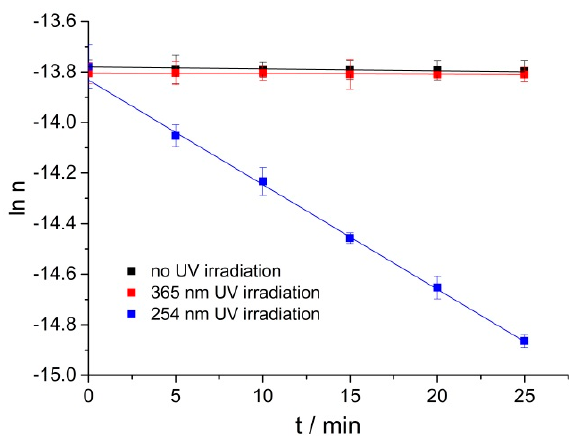
Figure 3. The change of natural logarithm of RPE moles with time under no UV irradiation, 365 nm and 254 nm UV irradiation at 40 °C.